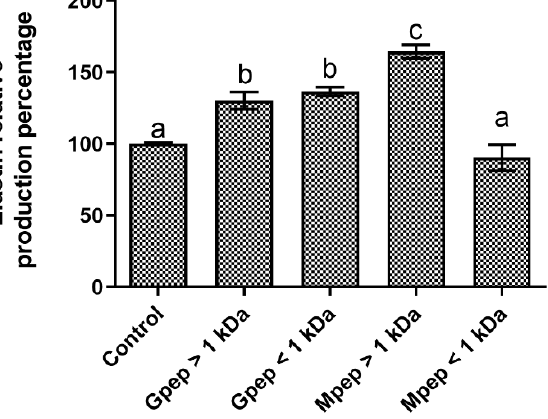
Figure 8. Elastin relative percentage of production in the presence of different peptide fractions relative to the basal level (control) in HDFa cells. Different letters represent the statistically significant differences ( p < 0.05) found between the samples tested.